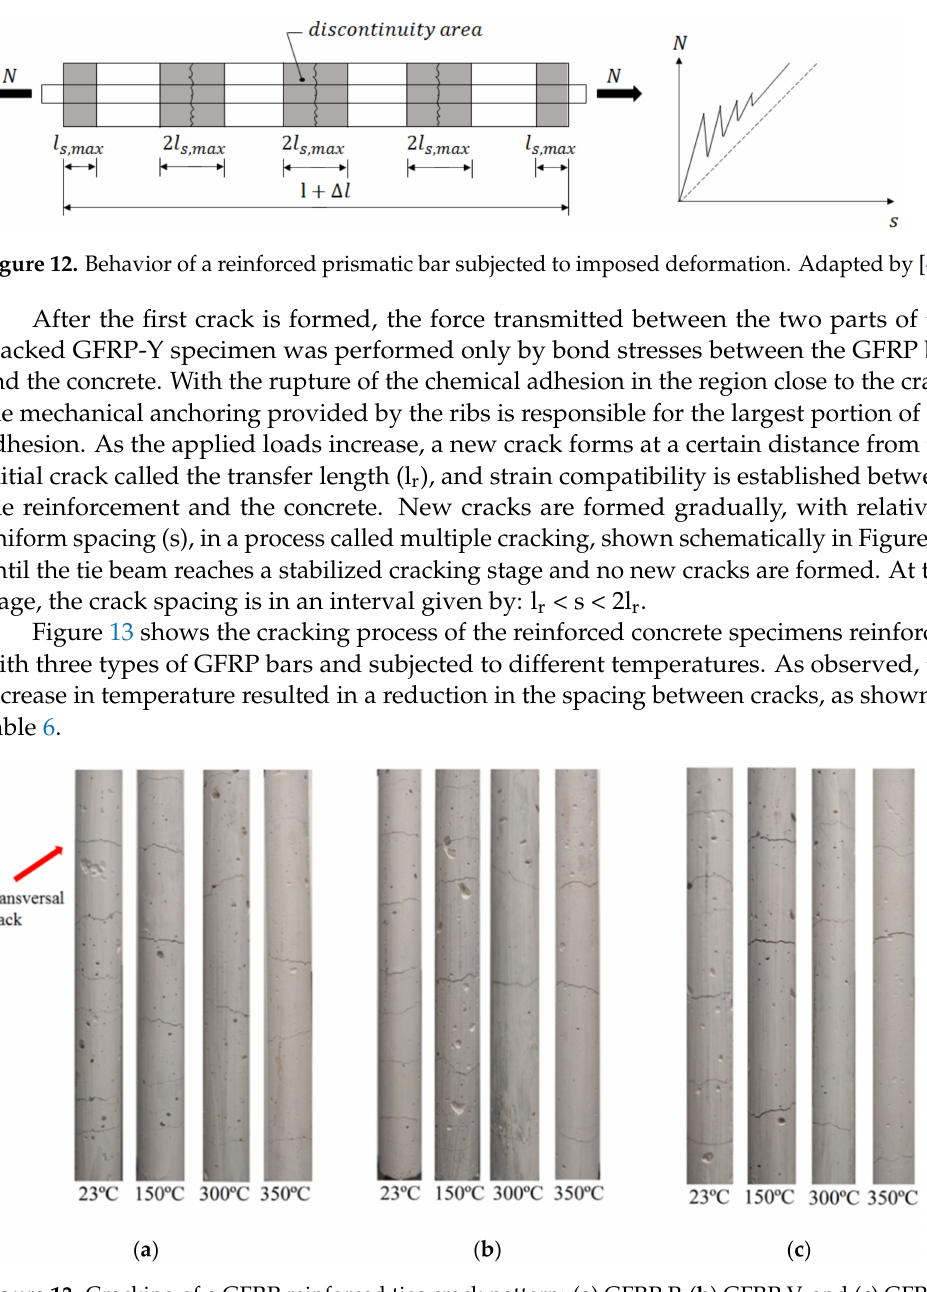
Figure 13. Cracking of a GFRP reinforced ties crack pattern: ( a ) GFRP P, ( b ) GFRP V, and ( c ) GFRP E subjected at 300 ◦